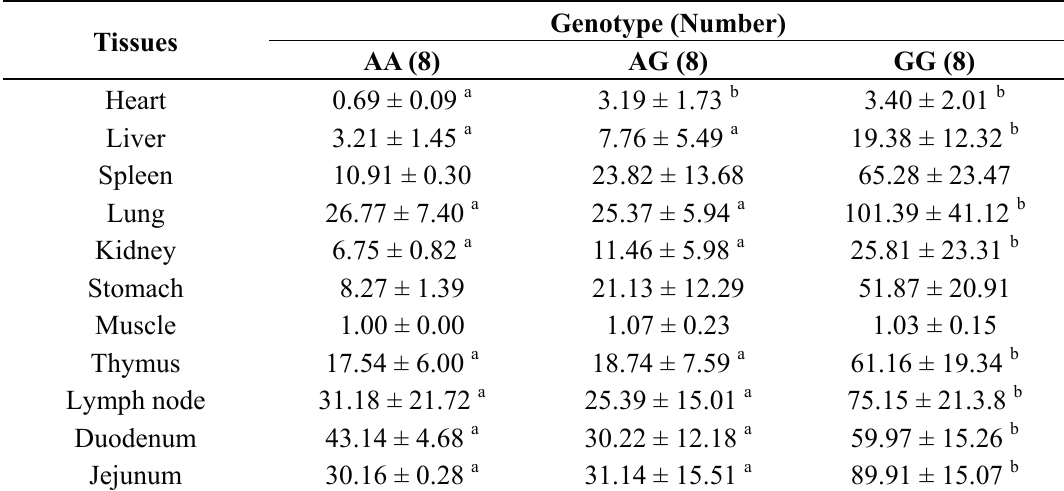
Table 3. Differential TAP1 mRNA expression levels in 11 tissues among different genotypes in Sutai